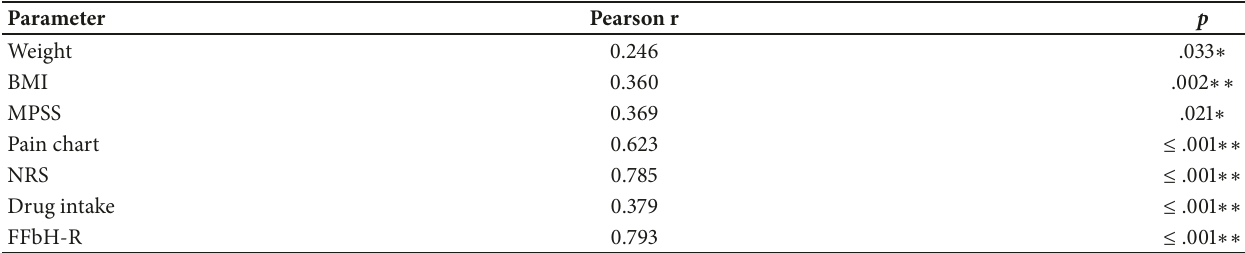
Table 4: Correlations with the